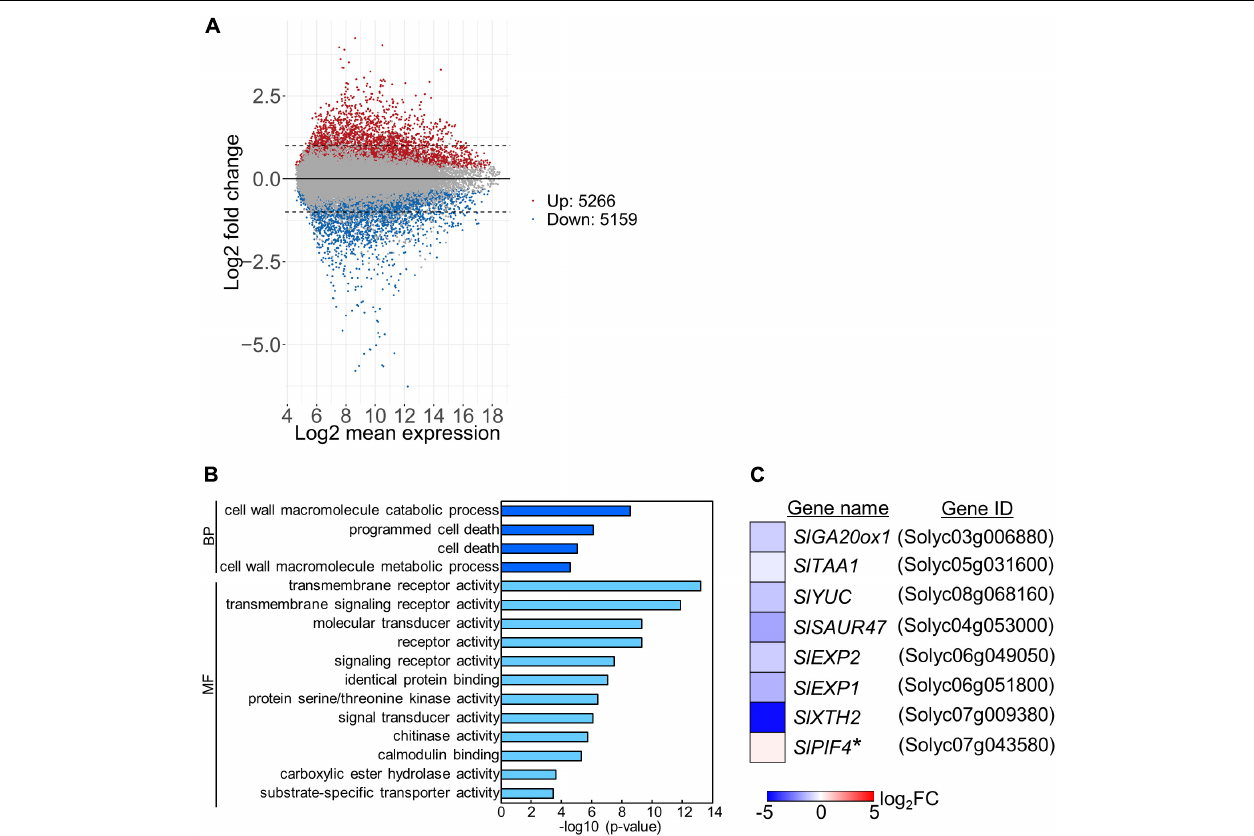
FIGURE 3 | Transcriptome analysis of tomato under positive and negative DIF treatments. Total RNA was extracted from epicotyls of tomato seedlings grown for 7 days under positive DIF and negative DIF and subjected to microarray analysis with three biological replicates. (A) , MA plots of microarray data in the positive DIF and negative DIF treatments. Red and blue dots represent genes upregulated (Up: 5266 genes) and downregulated (Down: 5159), respectively, under negative DIF in comparison with positive DIF. Gray dots represent genes that did not significantly differ between DIF treatments. (B) , GO terms enriched among the DEGs (top 300 upregulated and top 300 downregulated genes; P < 0.05) identified. (C) , List of 8 genes associated with stem elongation. The relative expression level of each gene under negative DIF compared with that under positive DIF is shown on the heatmap, which represents the log 2 fold-change (FC). The color scale is shown at